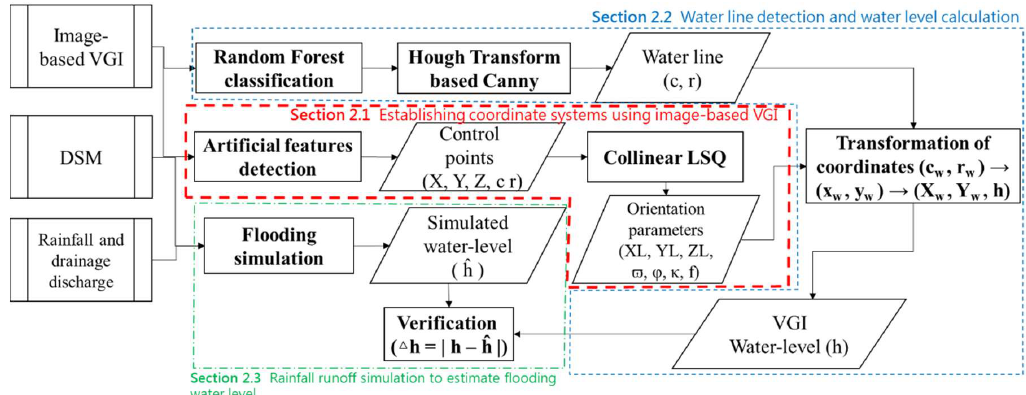
Figure 2. Flowchart for the proposed VGI water level detection method.